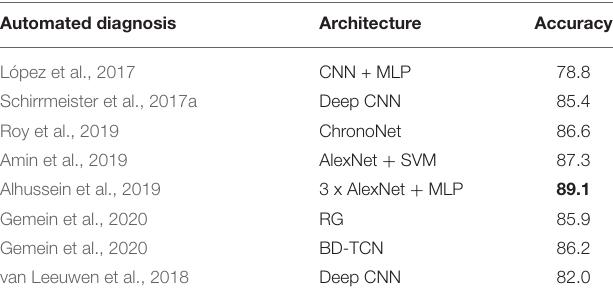
TABLE 1 | Related works on classification of normal/abnormal EEGs based on the TUH Abnormal EEG Corpus. Automated